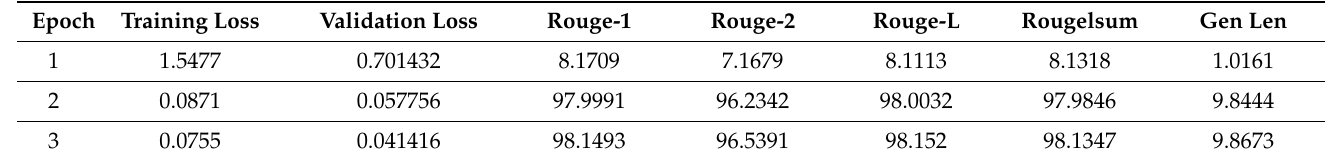
Table 8. Training process and results of Q2S before augmentation (on TRECQA-2017).